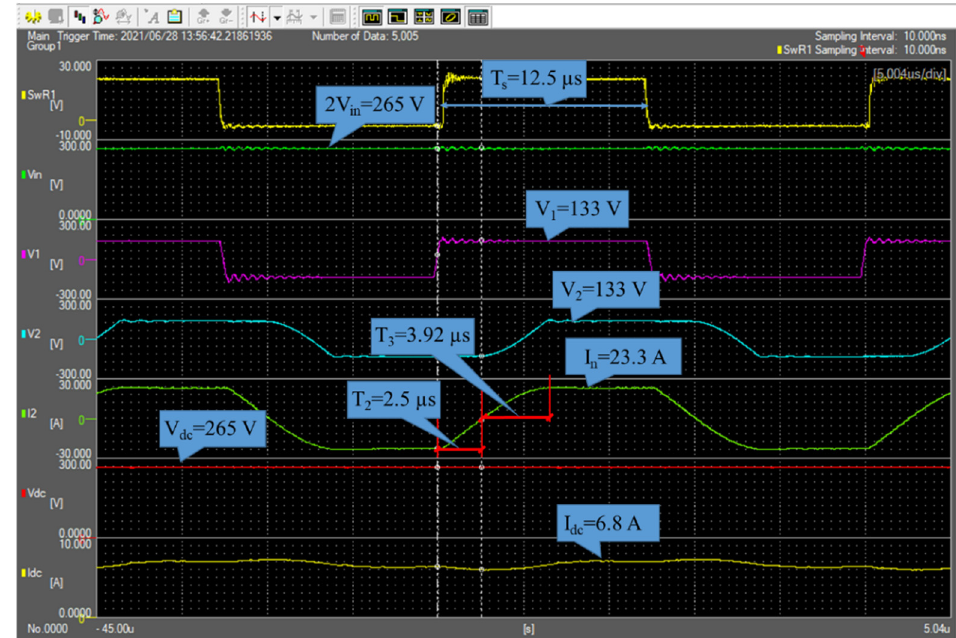
Figure 10. Experimental voltage and current waveforms at 𝑓 (cid:3046) = 40 kHz .